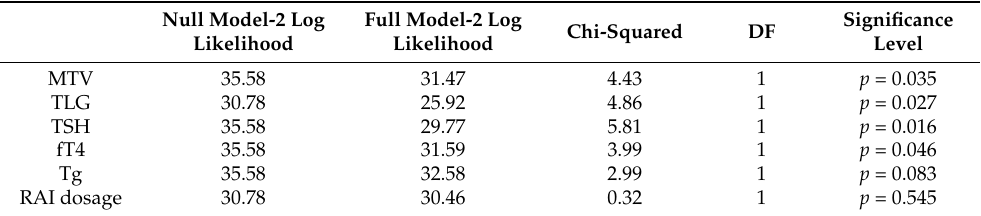
Table 3. Table reporting the results of Cox regression analysis of variables predicting the OS.